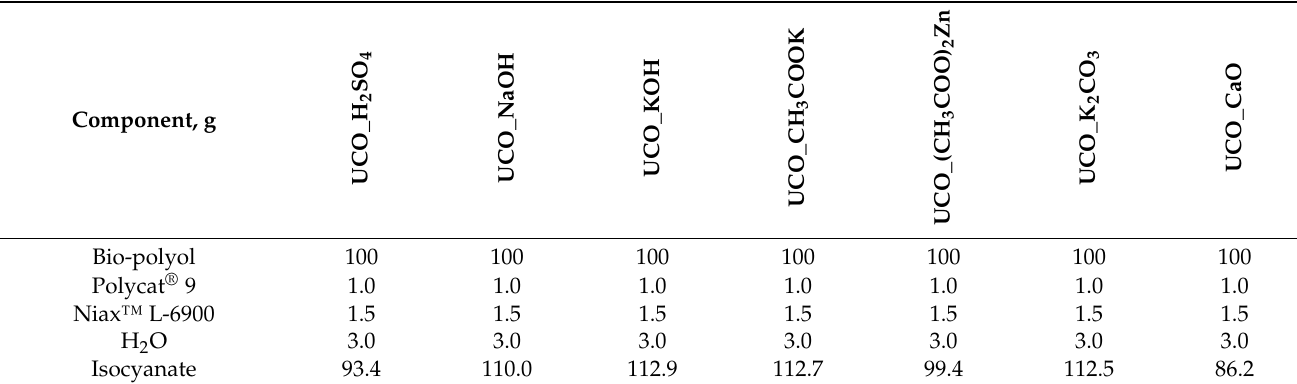
Table 1. Formulations of the